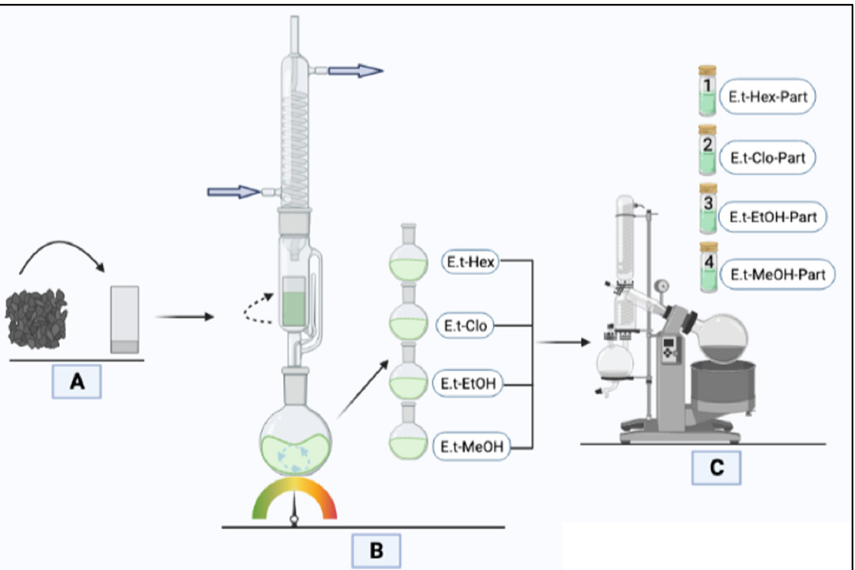
Figure 1. Flowchart of obtaining the partitions of E. tirucalli: ( A ) Filling the extractor by placing the dry plant material in a filter jacket. ( B ) Successive and independent distillations of the vegetal framework with different solvents (hexane, chloroform, ethanol, and methanol) to obtain the partitions. ( C ) Evaporation, under reduced pressure, of each partition to recover them free of solvents (1 < 2 < 3 < 4).